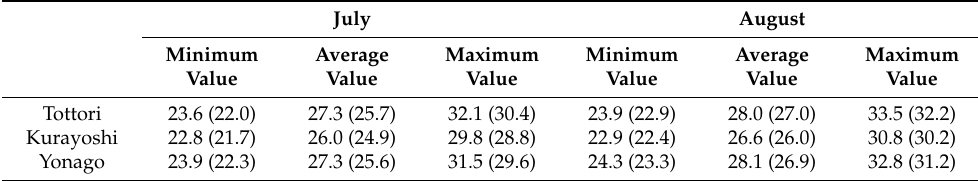
Table 1. Daily minimum, average and maximum air temperatures ( ◦ C) in three districts of the Tottori Prefecture during the study period (three year average for 2017–2019).